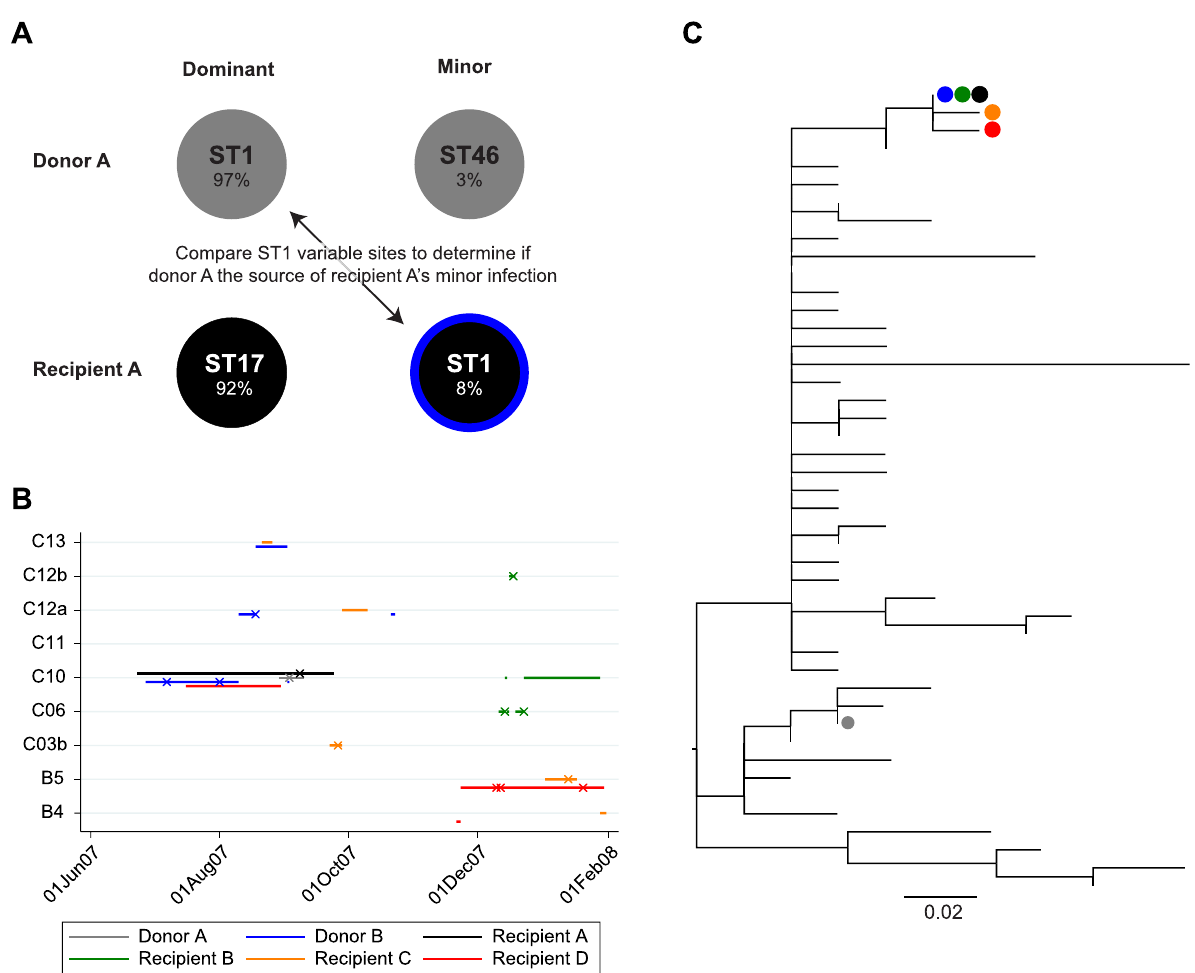
Figure 4. Phylogenetic and epidemiological relationships between cases related to a detected mixed infection. Panel A shows a depiction of the 2 mixed infections identified in donor A and recipient A. A transmission event from donor A to recipient A was predicted by a stochastic transmission model based on ward admission data. However donor A and recipient A had differing multilocus sequence types (STs) on initial testing of a single isolate from each case, suggesting a possible undetected mixed infection. Using the mixed infection estimator a minor ST infection in recipient A was found sharing the same ST, ST1 as donor A. However, applying the estimator to variable sites within ST1, the minor sequence in recipient A was most likely to have arisen from another case, donor B, shown in blue. Panel B shows the epidemiological relationships between donor A, recipient A, donor B and cases sharing similar sequences. Ward stays are shown as horizontal lines and positive tests as crosses. Panel C shows a phylogenetic tree of 45 distinct whole genome sequences from Oxfordshire patients with ST1 Clostridium difficile infection. Maximum likelihood tree based on 79 variable sites identified drawn using PhyML [36]. The donor proposed by the transmission model is shown in grey (donor A). The minor sequence in recipient A is shown in black, matching the sequence found in donor B, in blue. Recipient B shared an identical sequence to recipient A. Recipients C and D are two cases phylogenetically descended from the donor B, recipient A, recipient B sequences. Note only donor A and recipient A were analysed for the presence of mixed